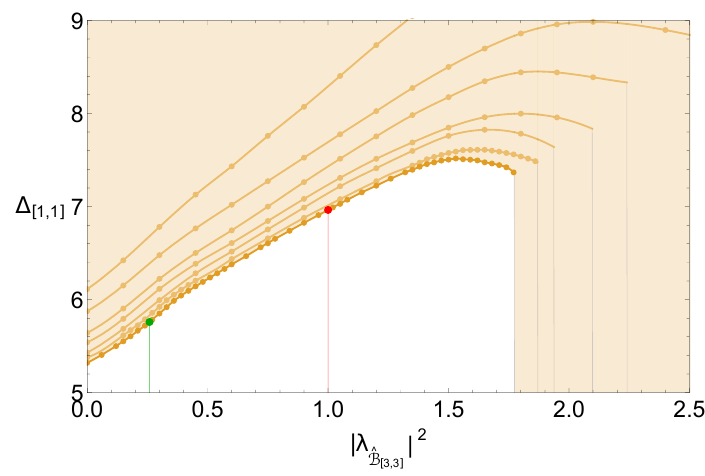
Figure 7 . Upper bound on the dimension of the long A (cid:1) > 4 as a function of the OPE coe(cid:14)cient [1 ; 1] ; 0 squared of ^ B for c (cid:0) 1 = 0 : 8. For each cuto(cid:11) (cid:3) the bounds end abruptly at the value corresponding [3 ; 3] to the maximum value j (cid:21) ^ j 2 can have, as read o(cid:11) from (cid:12)gure 3 at c (cid:0) 1 = 0 : 8. The green line B [3 ; 3] marks the expected value for the OPE coe(cid:14)cient for the c (cid:0) 1 = 0 : 8 N = 3 SCFT (5.5) with the green dot providing an upper bound for this OPE coe(cid:14)cient, while the red line marks the value for N = 4 SYM. The strongest bound corresponds to 24 derivatives, and they are reduced in steps of